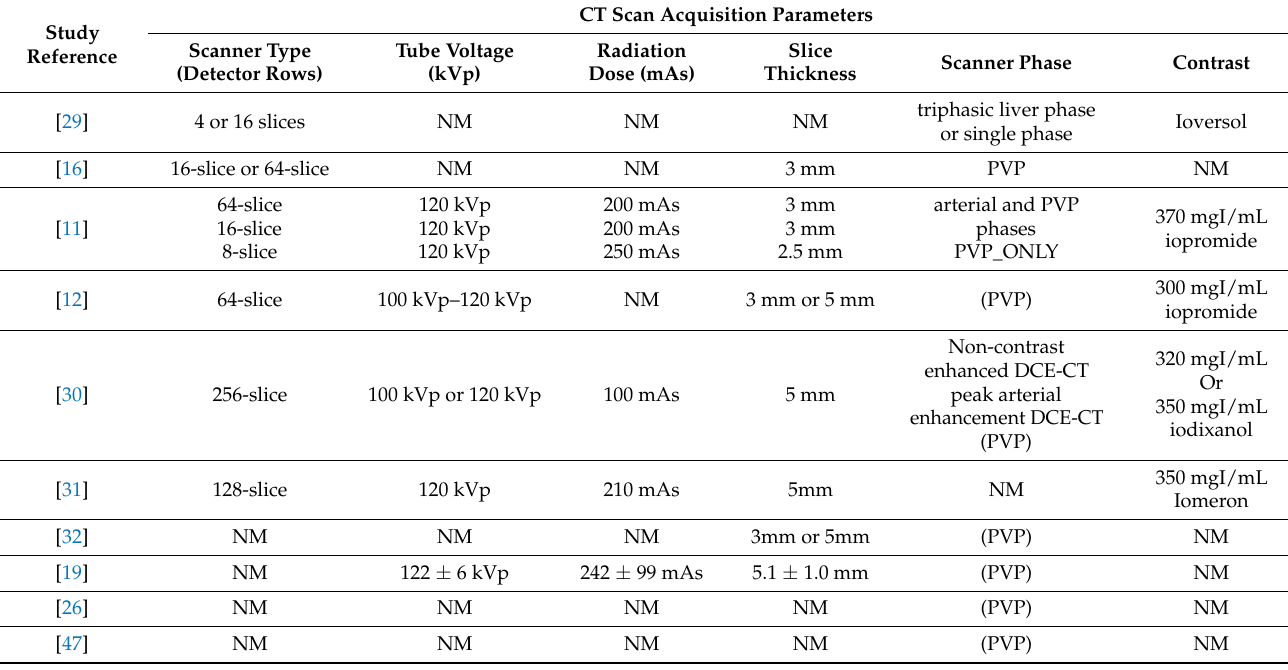
Table 1. Comparison between studies based on CT scan